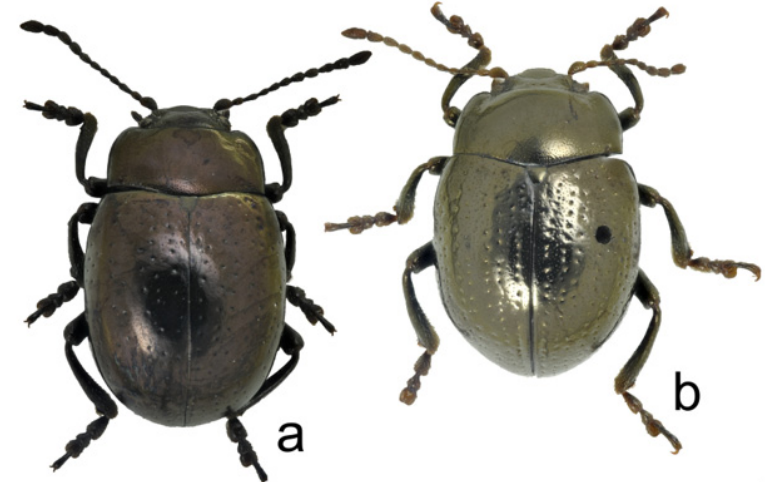
Figure 13. Chrysolina , total dorsal view: ( a ) Ch. igori sp. nov., holotype, male; ( b ) Ch. genriki sp. nov., holotype, male.